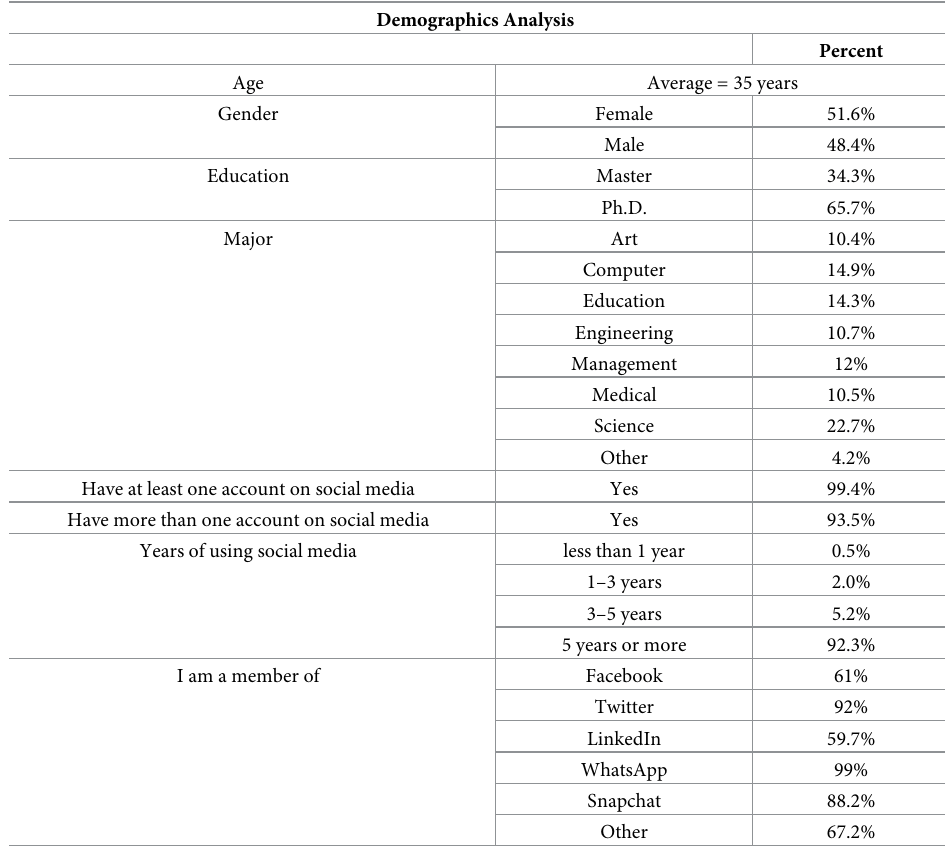
Table 2. Demographics analysis of Saudi faculty and social